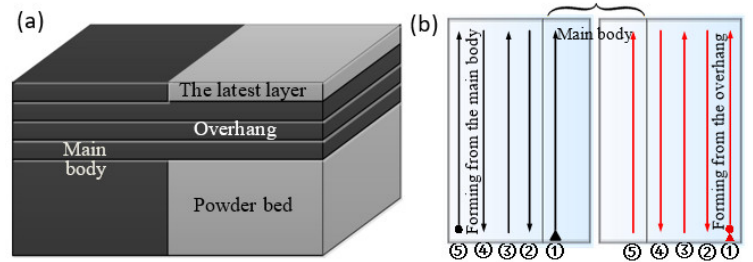
Figure 1. ( a ) Diagram of coupled thermo-mechanical model; ( b ) Laser scanning strategy and overhang forming direction.